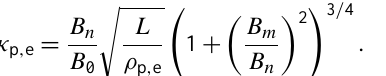
Fig. 5. Panel (a) shows the distribution of B 0 , the value of the mag- netic field B l at the CS boundary. Panels (b) and (c) present distri- butions of absolute values of perpendicular B n and shear B m com- ponents. The averaged values (over all 29 CSs) are shown at the